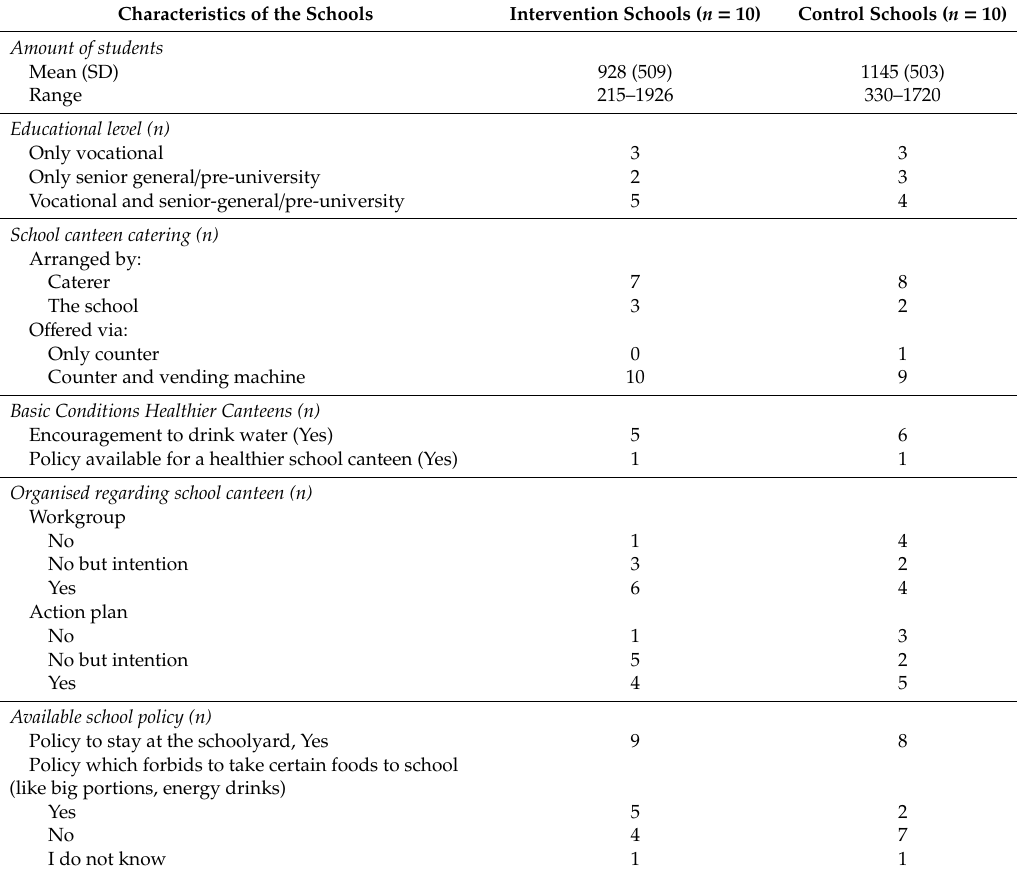
Table 2. Characteristics of the participating intervention and control